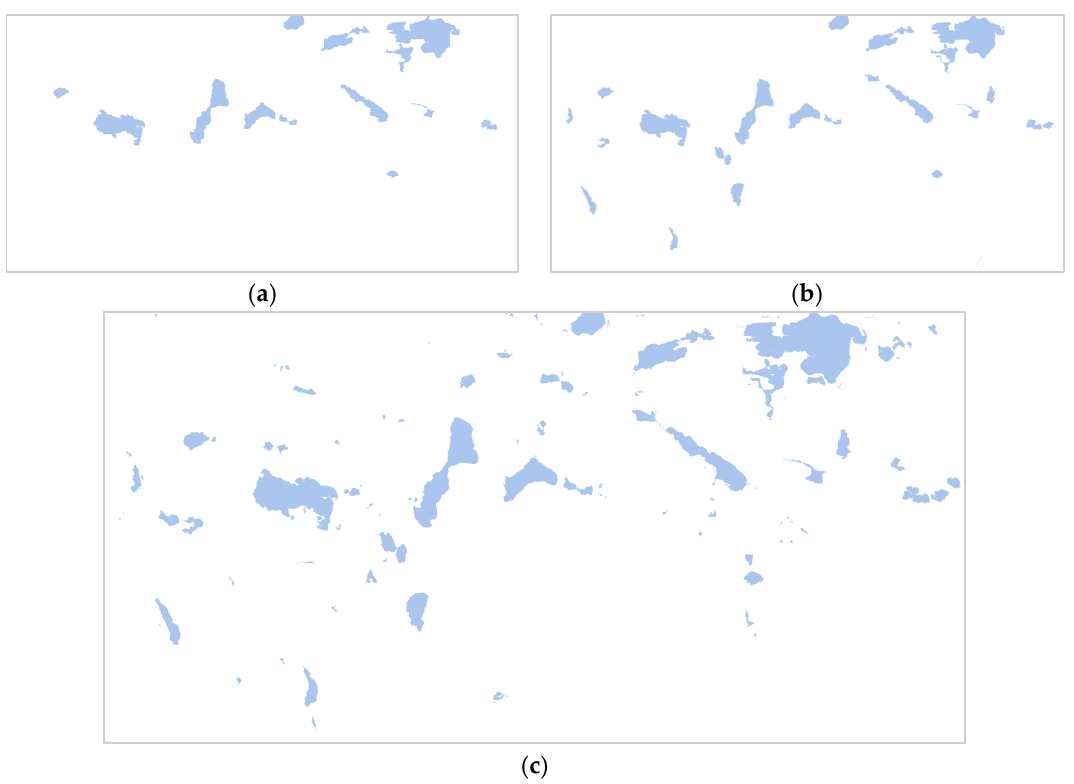
Figure 12. Experimental data after extraction. ( a ) Tenth level; ( b ) Eleventh level; ( c ) Twelfth level.